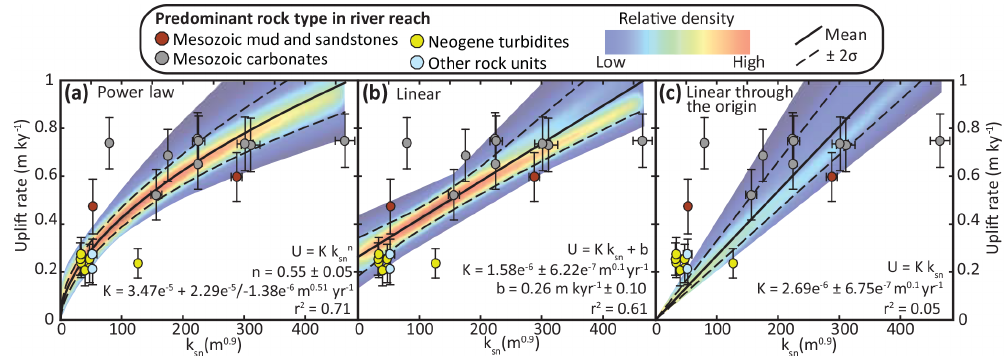
Figure 7. Plots of the normalized steepness index ( k sn ) for the lowest river reaches (Fig. 6a) versus modeled uplift rate from marine terrace (Fig. 3b). The predominant rock type underlying each river reach is noted. Each panel shows the mean (solid black line), ± 2 σ uncertainties (dashed black lines), and relative path density (colored background) from a bootstrap regression analysis using 1000 trials. Regressions are used to calibrate parameters in the stream power incision model under different assumptions and are only valid based on the condition that each river reach erodes at the same rate as local rock uplift. (a) A power-law regression, (b) unconstrained linear regression, and (c) linear regression forced through the origin. All parameter uncertainties are presented as ± 2 σ